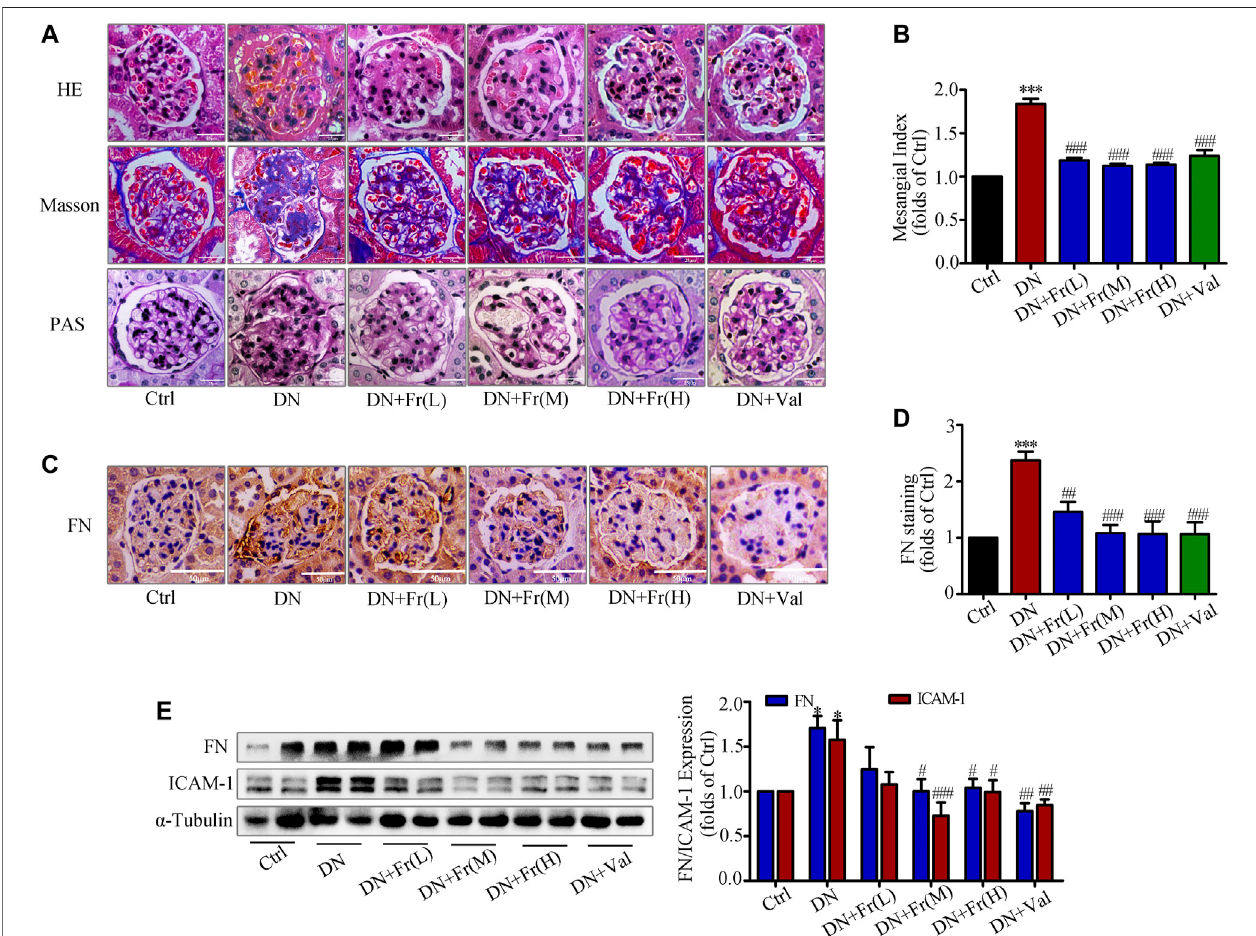
FIGURE7| Frreducedthedegreeofrenal fi brosisindb/dbmicebyinhibitingtheproteinexpressionofFNandICAM-1. (A) Glomerularhistopathologyanalysiswas performed by PAS, HE and Masson staining(×400 magni fi cation). Bar: 25 μ m, n = 6 (B) Statistical analysis ofmesangial index. (C) The expression of FN in the glomeruli wereshown by immunohistochemical staining (×200 magni fi cation).Bar: 50 μ m, n =6. (D) StatisticalanalysisofFN protein expression. (E) The levels ofFN and ICAM-1 in kidney tissues of db/db mice were detected by the western blot assay. Independent experiments were performed at least three times with similar results. * p < 0.05, *** p < 0.001 vs . Ctrl; # p < 0.05, ## p < 0.01, ### p < 0.001 vs .